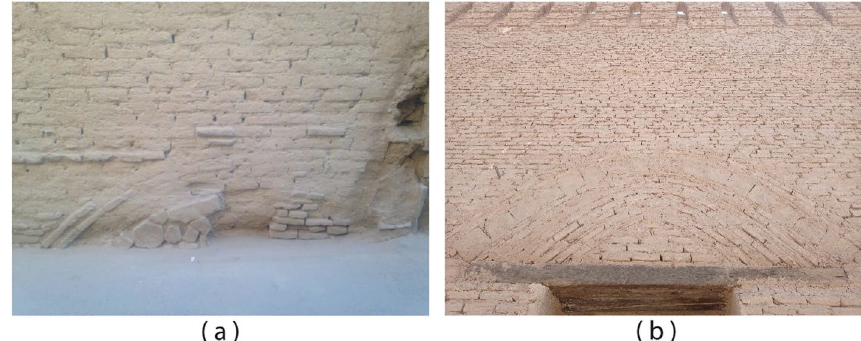
Fig. 13 Discharging vaults in Yazd earthen architecture: ( a ) in the base of adobe walls (Source: Ehsan Raad) and ( b ) in combination with a timber lintel above the opening (Source: the